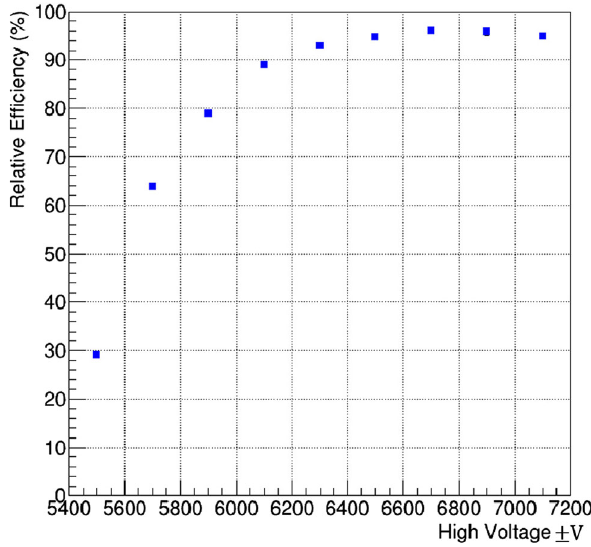
Fig. 18 MRPC detection efficiency vs. HV at CSR